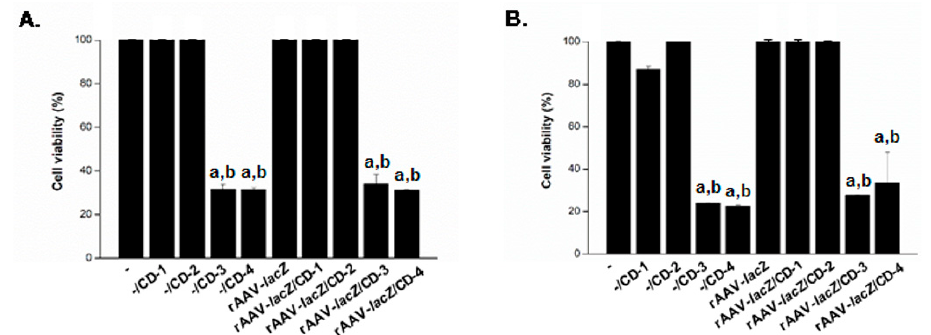
Figure 4. Cell viability in hMSCs transduced with the rAAV / CD systems. The rAAV- lacZ vector (20 µ L, 4 × 10 5 transgene copies) was formulated with the various CDs (CD-1 to CD-4; 20 µ L) and the resulting rAAV / CD systems (40 µ L, i.e., 4 × 10 5 transgene copies) were incubated with hMSCs (3,000 cells in 96-well plates; MOI = 133) for up to 10 days. Cell viability was examined after one ( A ) and 10 days ( B ) using the Cell Proliferation Reagent WST-1. Control conditions included CDs lacking rAAV (- / CD), free rAAV (rAAV- lacZ ), and absence of both CD and rAAV (-). Statistically significant relative to a - and b rAAV- lacZ .